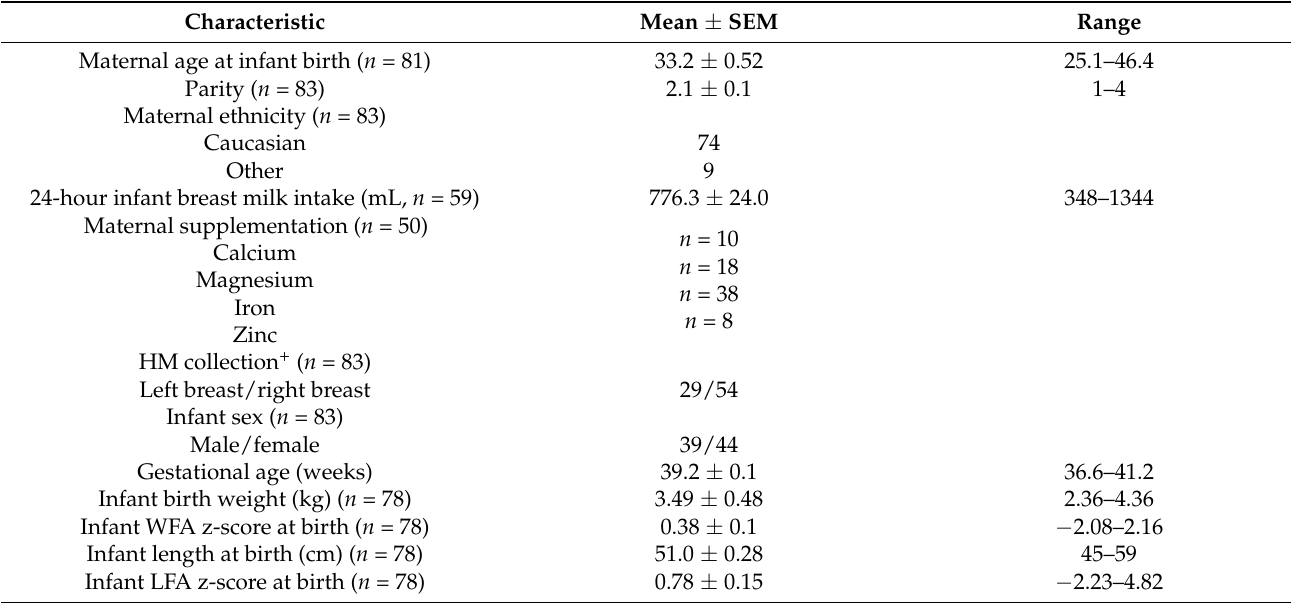
Table 1. Demographic characteristics of the cohort. Data shown as mean ± SEM with given ranges where appropriate, unless stated